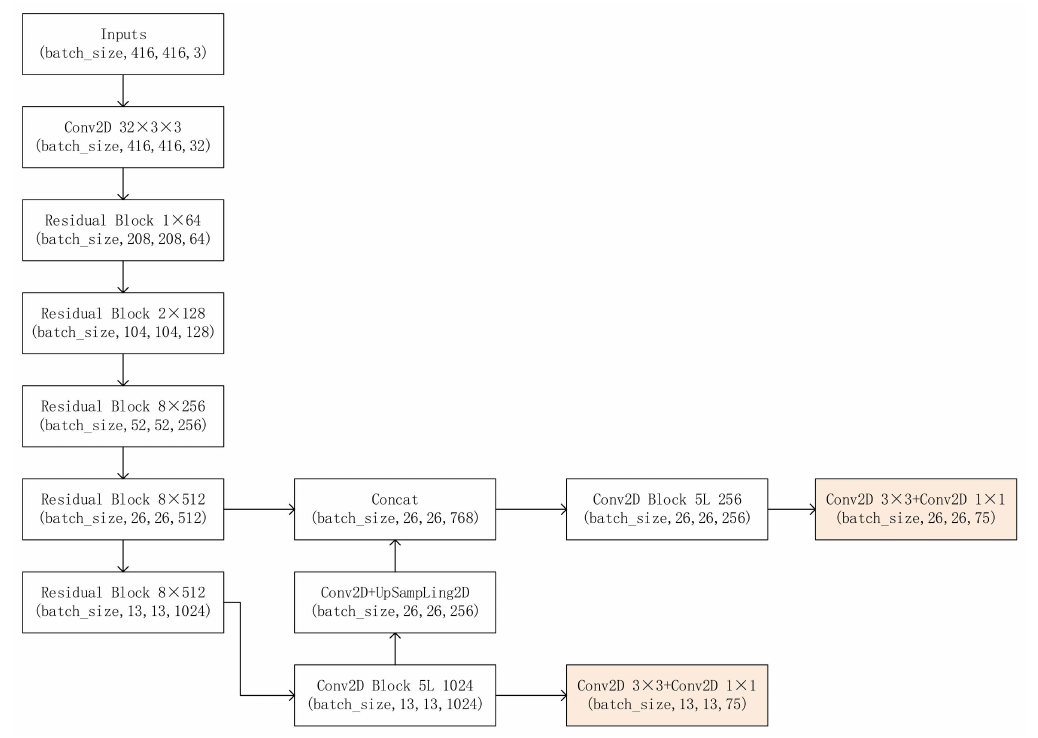
Figure 5. Improved YOLOv3